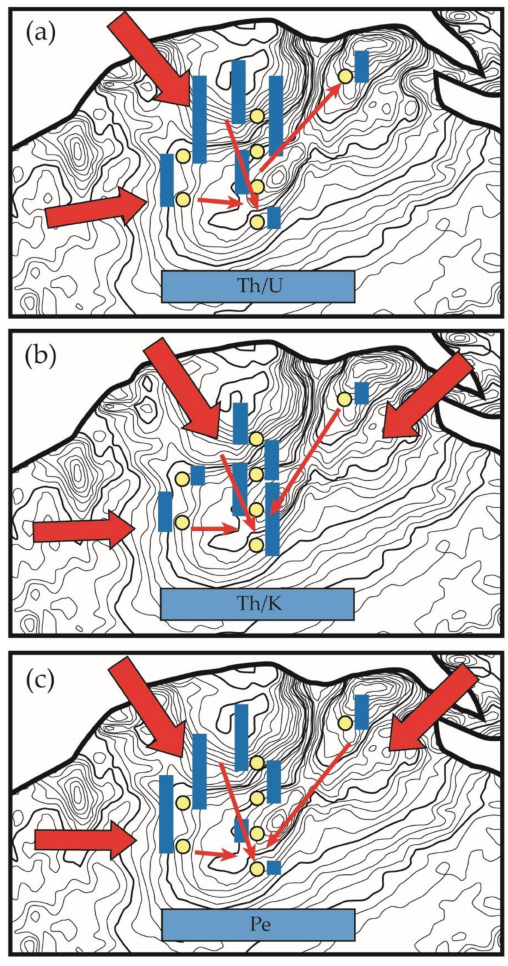
Figure 5. Schematic maps for the directions of paleocurrents based on ( a ) Th/U, ( b ) Th/K, and ( c ) Pe. Blue bars indicate the data for each well, corresponding to Table 1; however, 1, 4, and 3 were subtracted from averaged Th/U, Th/K, and Pe data, respectively, to clarify the differences. Black lines are paleoelevations. Red arrows indicate the directions of paleocurrents. Table 2. Dip logging data derived from seven wells from the Es 3L Formation in the Chezhen depression. Well/Sandset